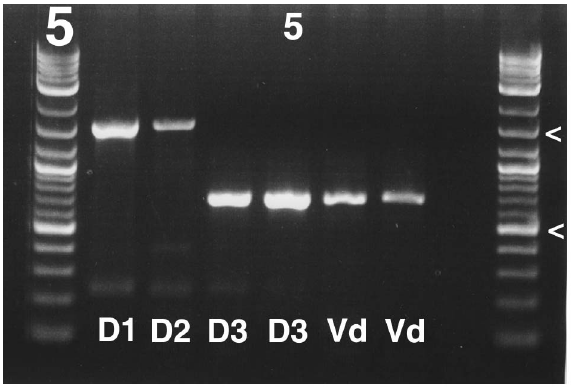
Figure 5. Verticilliumlongisporum lineage A1/D3 lacks a 839-bp SSU rRNA intron that is present in the other V.longisporum lineages. Agarose gel of Bas3/NS6 amplicons. Gel is delimited by 2-log ladders, penultimate lane is negative control, and relevant size markers are indicated by ‘ , ’ and correspond to 500 bp and 1500 bp, respectively. Lanes are numbered from left to right; fifth lane is numbered. Abbreviations below bands refer to V. longisporum lineages and V. dahliae . For information on isolates selected see text. Lane 2: V. longisporum lineage A1/D1 strain PD590. Lane 3: V. longisporum lineage A1/D2 strain PD730. Lane 4: V. longisporum lineage A1/D3 strain PD614. Lane 5: V. longisporum lineage A1/D3 strain PD715. Lane 6: V. dahliae strain Ls.1875. Lane 7: V. dahliae strain